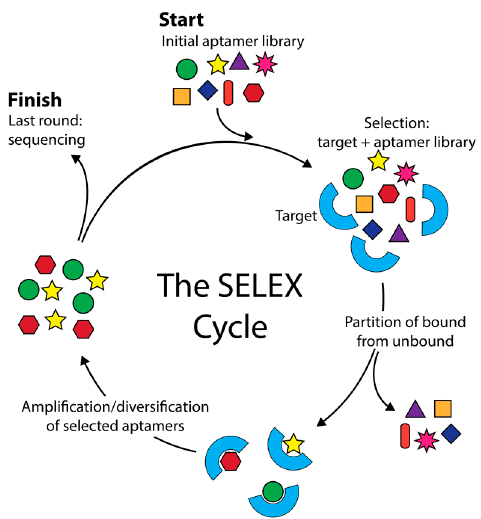
Figure 1. The SELEX (Systematic Evolution of Ligands by Exponential Enrichment) cycle. SELEX starts with a random nucleic acid aptamer library which is used to initiate the SELEX cycle (top arrow entering cycle). The library is incubated with the target and the target is washed to remove and discard unbound aptamers (right arrow exiting cycle) before the bound aptamers are eluted and amplified by PCR. The amplified sequences seed the next round of SELEX. Typically, around 12 SELEX cycles are performed before sequencing and aptamer characterization (left arrow exiting cycle).